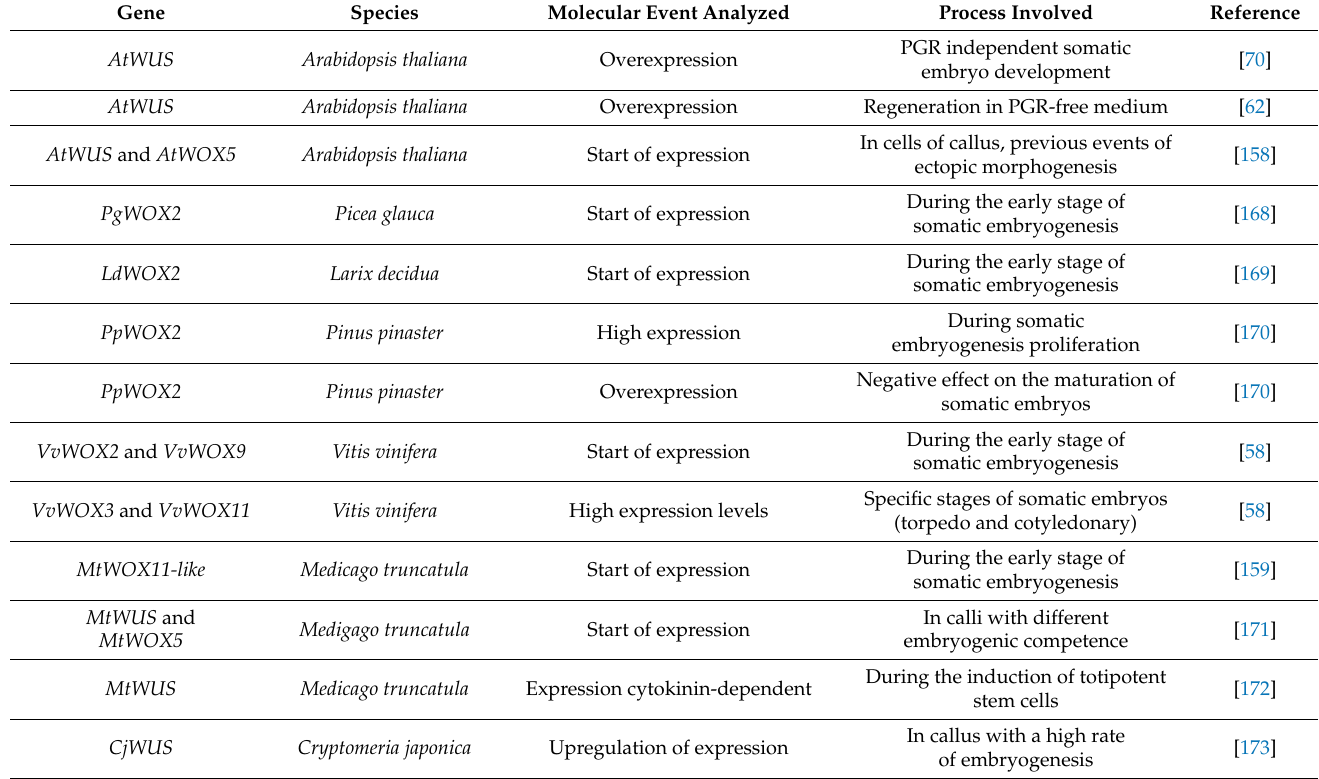
Table 1. Involvement of WUS and WOX genes in somatic embryogenesis and organogenesis in vitro, observed in different herbaceous and tree